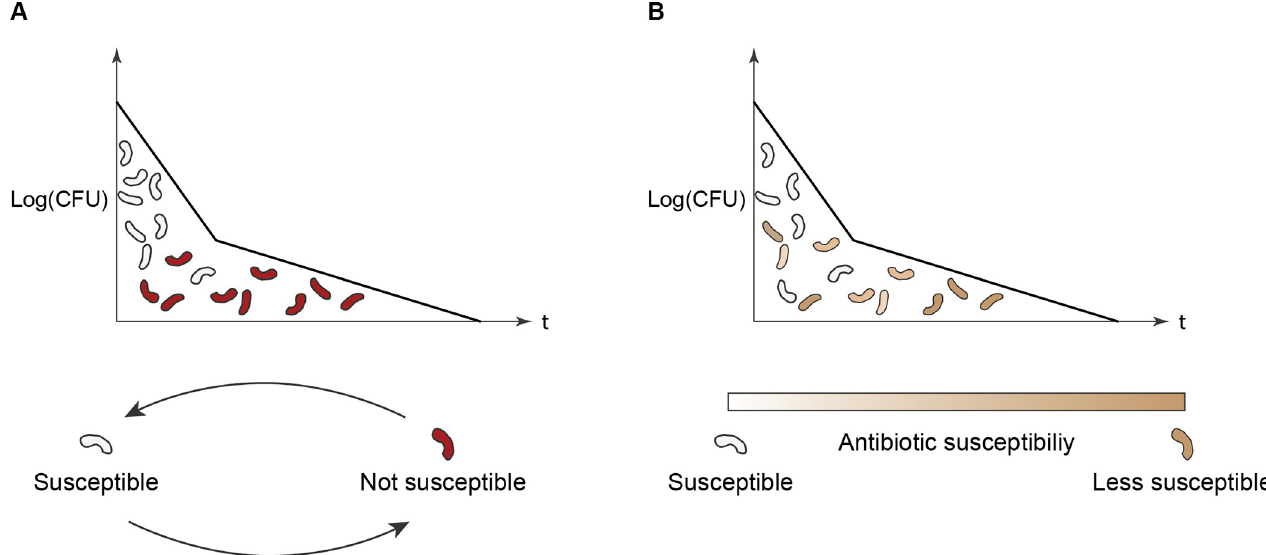
Fig 1. Mechanisms that can result in a slowdown in bacterial decline: persistence and heteroresistance. In both cases, X-axis is the time and the Y axis is the number of bacteria. Fig 1A illustrates persistence where bacteria switch back and forth between a susceptible and non-susceptible state over time only the non- susceptible ones remain. These are only killed when they exit a non-susceptible state. Fig 1B illustrates heteroresistance that is defined by a diversity within the susceptibility on antibiotics within the population of bacteria, some subpopulations will end up being killed at a slower pace.